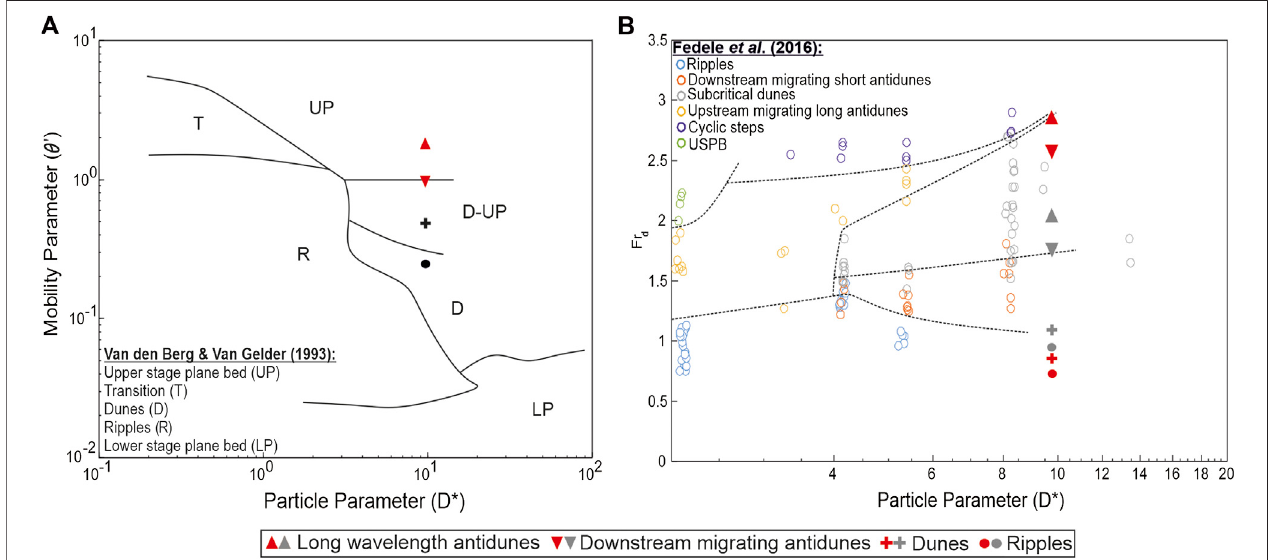
FIGURE 13 | Bedforms developed during the present experiments are plotted onto bedform phase diagrams for open-channel and density driven fl ows. (A) Van den Berg and Van Gelder ’ s (2009) dimensionless phase diagram. (B) A modi fi ed version of Fedele ’ s et al . (2016) new bedform phase diagram for density currents: Particle parameters ( D *) were calculated and re-plotted against Fr d . The red markers signify bedforms and associated Fr d numbers calculated for the lower layer of the current. Grey markers signify the same bedforms and associated Fr d numbers calculated for the entire current.